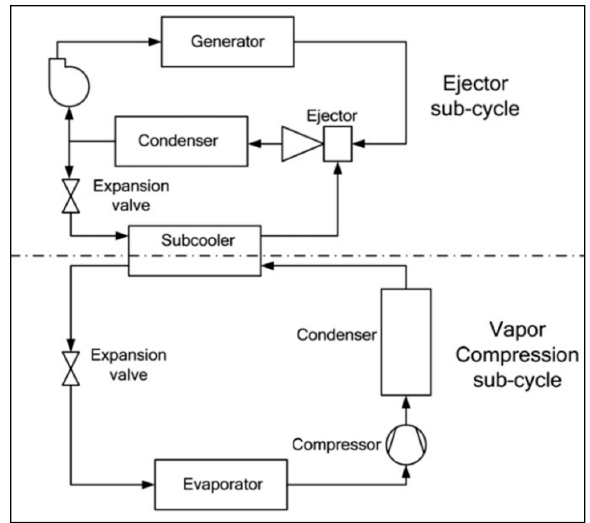
Figure 36. Combined ejector–vapor compression cycle using R134a [155].